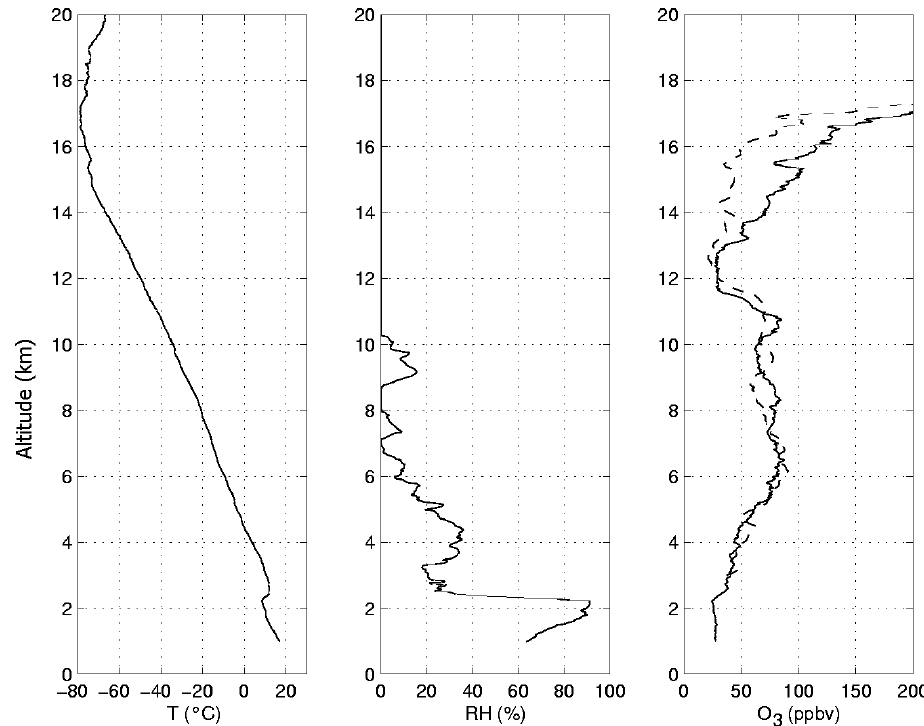
Figure 6 Fig. 6. Temperature (left), relative humidity (middle) and ozone mixing ratio (right) profiles obtained by ozonesounding on 2 December